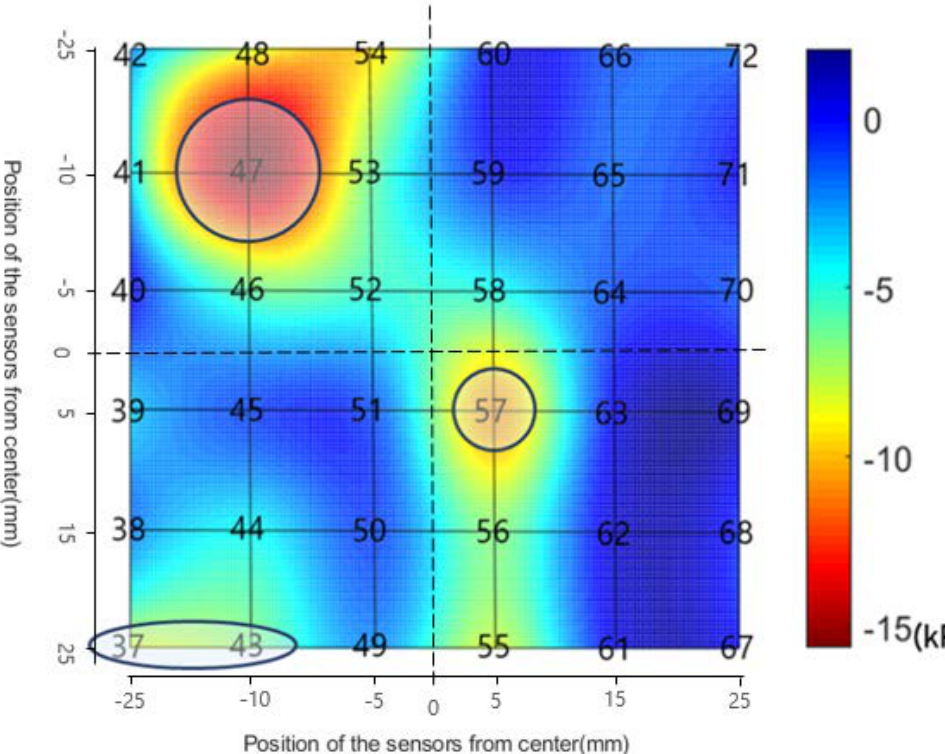
Figure 30. Contour for Discrepancy in Peak Pressure (the 2 nd Case Pressure -Wet Average, SWAY).